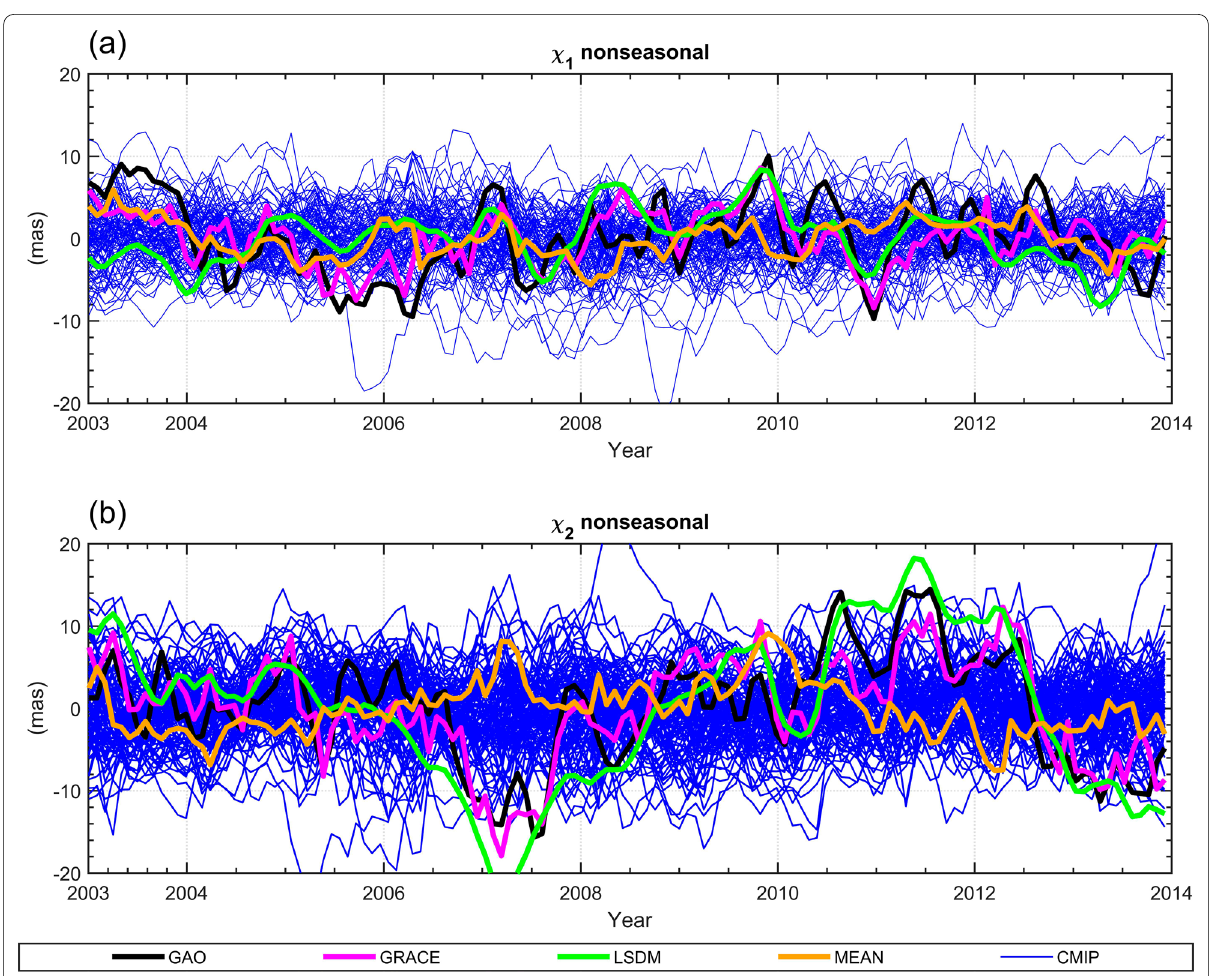
Fig. 9 a χ 1 and b χ 2 components of non-seasonal oscillations in GAO and HAM computed from GRACE, LSDM, CMIP6 models and MEAN